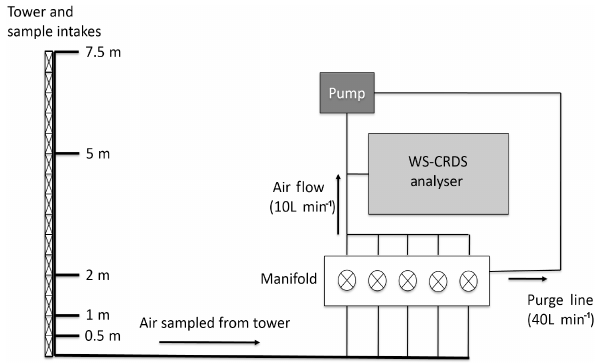
Figure 3. Chamber design used for determining the isotopic com- positions of ET